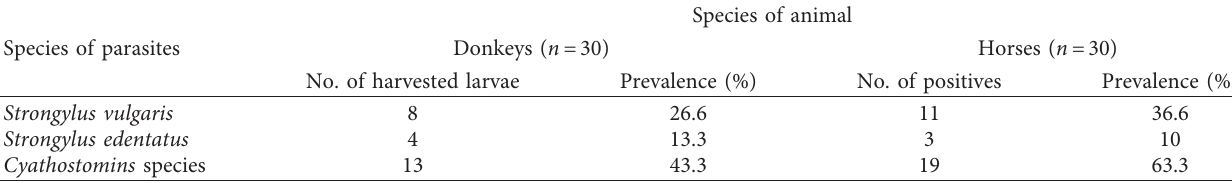
Table 4: Frequency of GI helminths in donkeys and horses after fecal